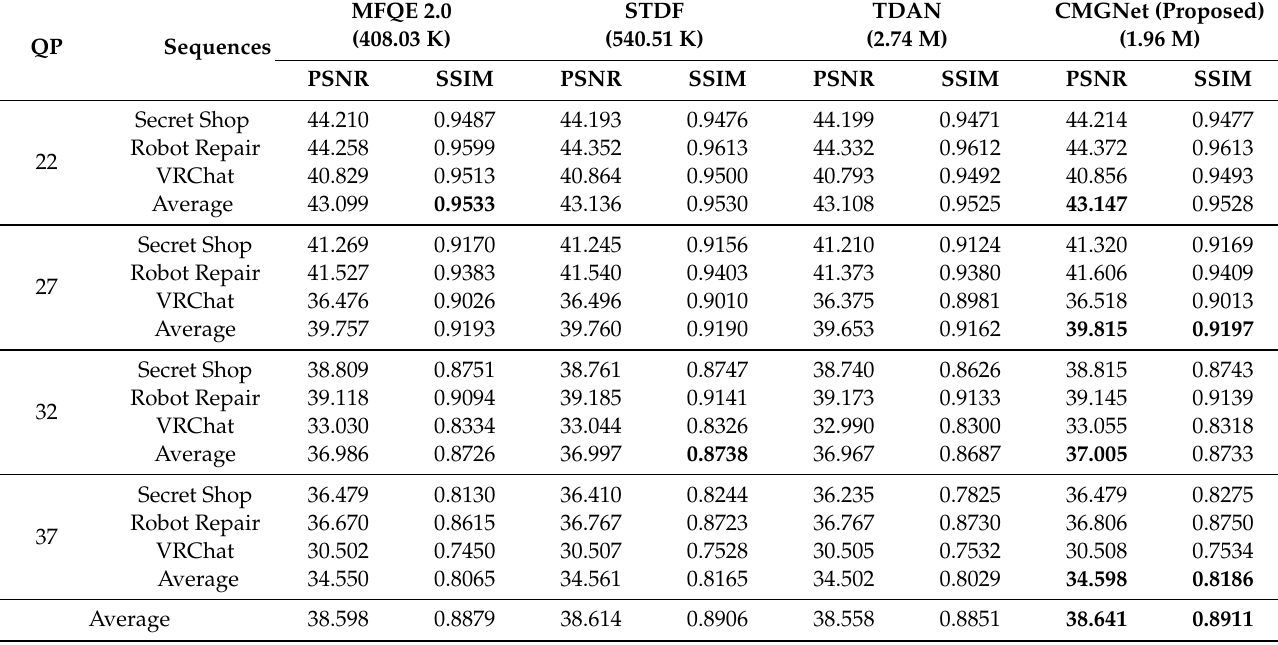
Table 4. Comparison to